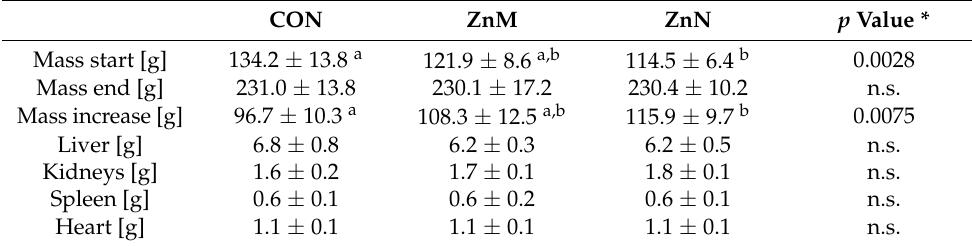
Table 2. Characteristic of experimental groups.